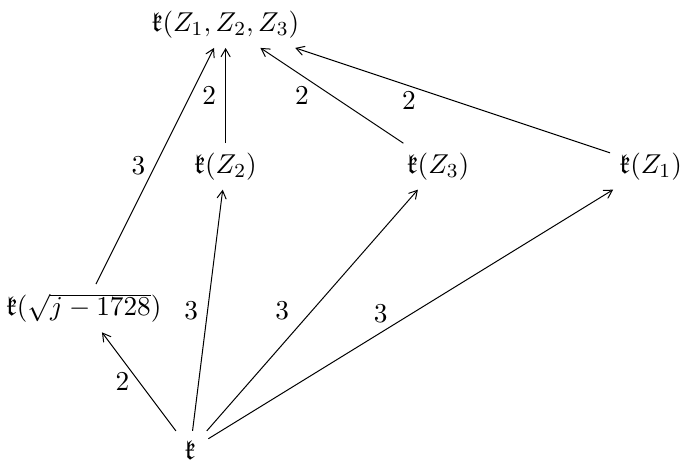
Figure 5 . Field extensions generated by the roots of the characteristic polynomial for massive vacua of N = 1 (cid:3) theory with su (2) gauge algebra. The integer on each arrow indicates the degree of the (cid:12)eld